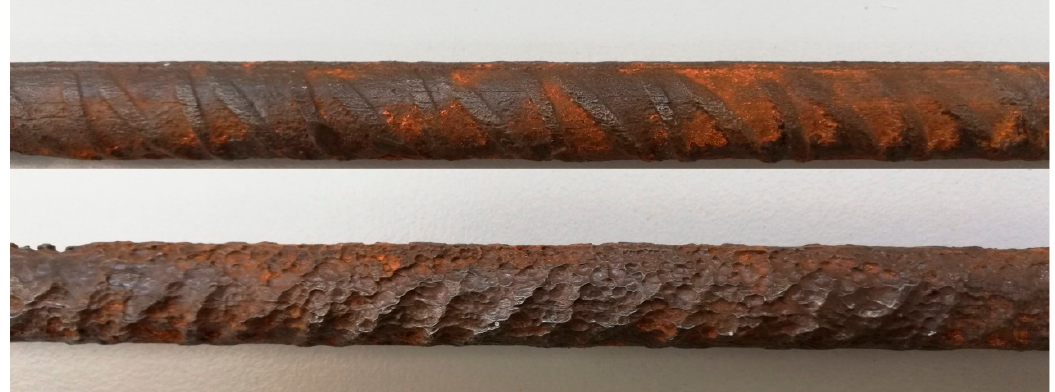
Figure 12. ( Up ) Inner half of steel bar's circumference. ( Down ) Outer half of steel bar's circumference.